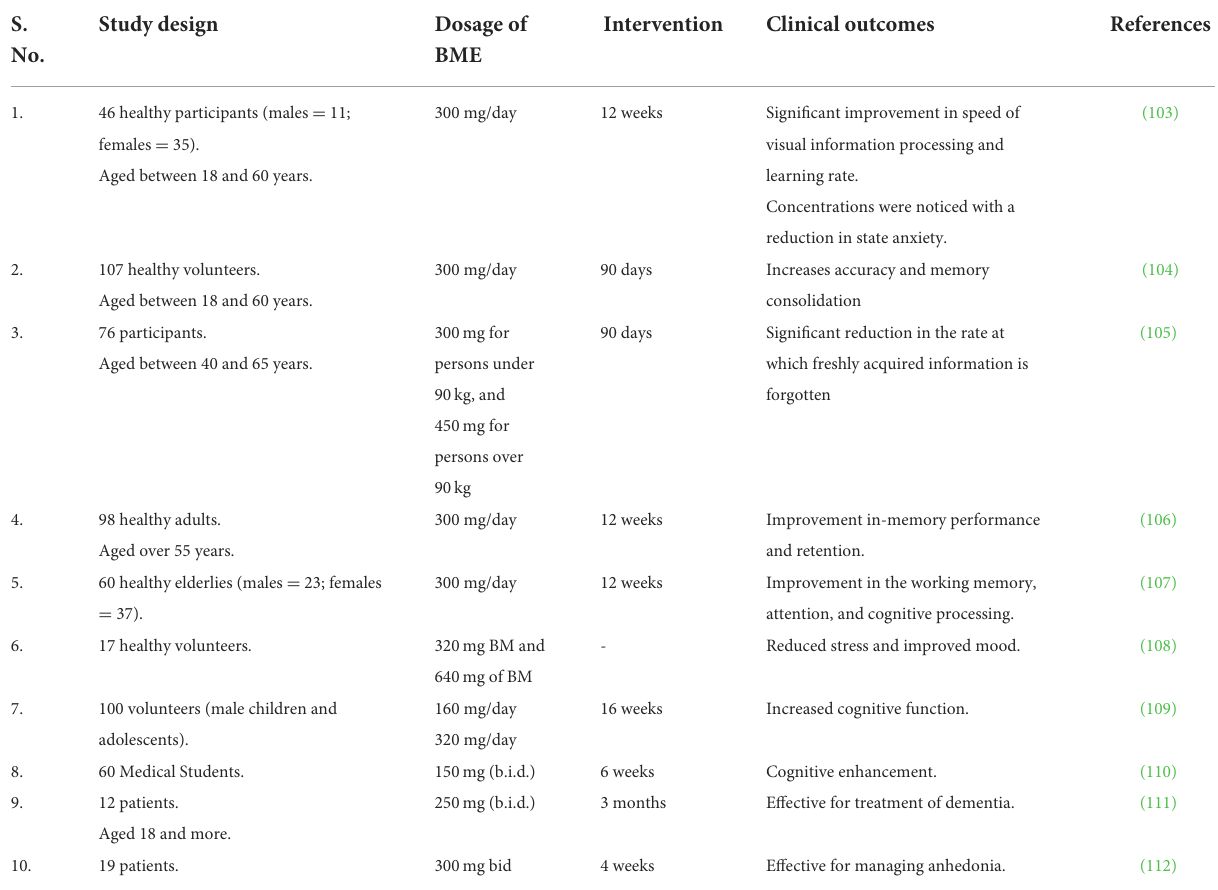
TABLE 2 Summary of various clinical